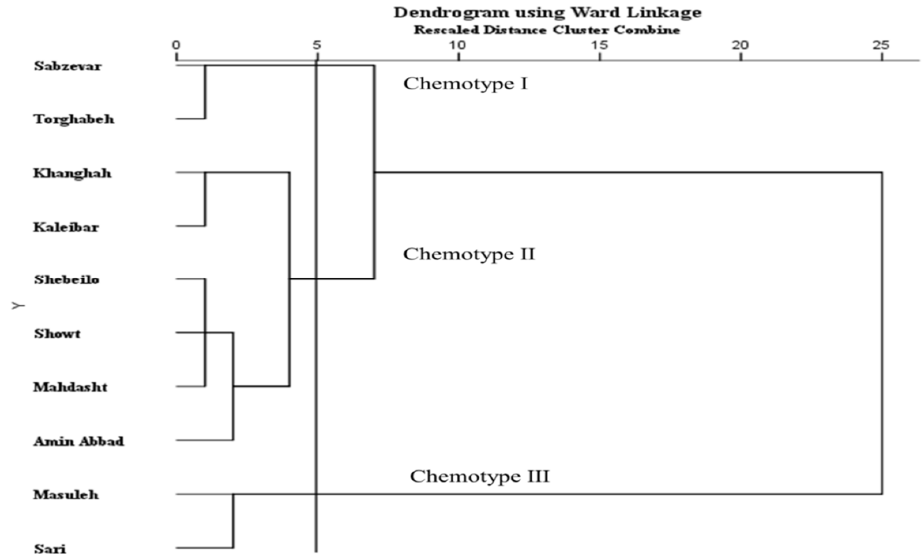
Figure 2. Cluster analysis of 10 populations of H. persicum based on EO components. Populations were clustered using Ward Linkage algorithm.